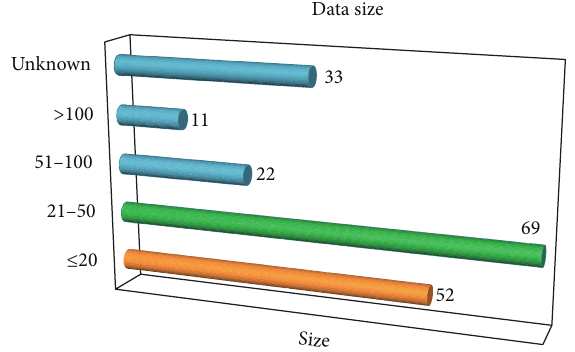
Figure 3: Frequency distribution of data size in keystroke dynamics experiments.